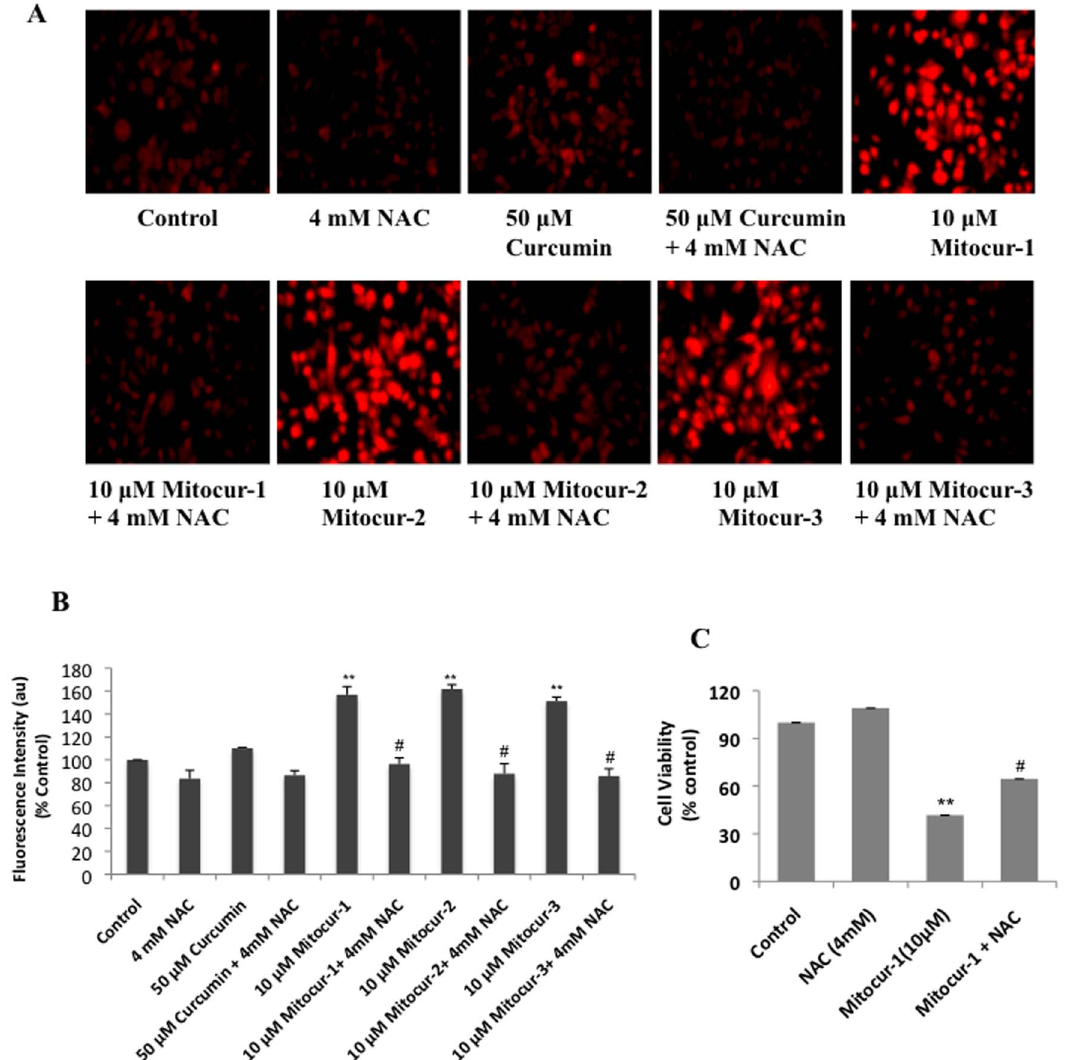
Figure 2. Mitocur-1, 2 and 3 induces superoxide generation in MCF-7 cells. ( A ) Ethidium fluorescence of MCF-7 cells treated with curcumin (50 m M) and mitocur-1, 2, 3 (10 m M) for 4 h. All experiments were performed with and without NAC (4 mM). Representative fluorescence images are shown. ( B ) shows quantification of fluorescence intensities shown in A. **, significantly different compared to control (P , 0.01) and # , significantly different compared to mitocurcuminoid-1, 2 and 3 (P , 0.01). ( C ) cells were treated with or without 10 m M mitocurcuminoid-1 and 4 mM NAC for 24 h. Results are expressed percentage of viable cells compared to control. Data represented is from at least three independent experiments. **, significantly different compared to control (P , 0.01) and # , significantly different compared to NAC (P ,